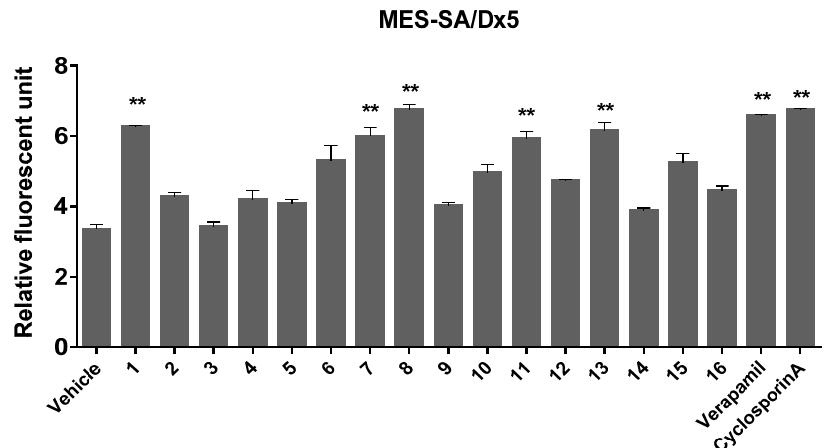
Figure 5. Inhibitory effects of isolated compounds against multidrug-resistant (MDR) protein-mediated drug efflux. MES-SA/Dx5 cells were treated with 10 μ M of each compound and vehicle (0.1% DMSO in PBS), while verapamil or cyclosporine A were controls. This was followed by addition of cell-based Calcein AM/Hoechst dye staining solution, and its uptake was analyzed using a plate reader and normalized to cell densities measured using fluorescence intensity of Hoechst dye staining. Data are means ± SD of one duplicated representative experiment. Differences between each treatment group against LPS control group were analyzed and statistical significances are denoted as ** p < 0.01. DMSO, dimethyl sulfoxide; PBS, phosphate-buffered saline; SD, standard